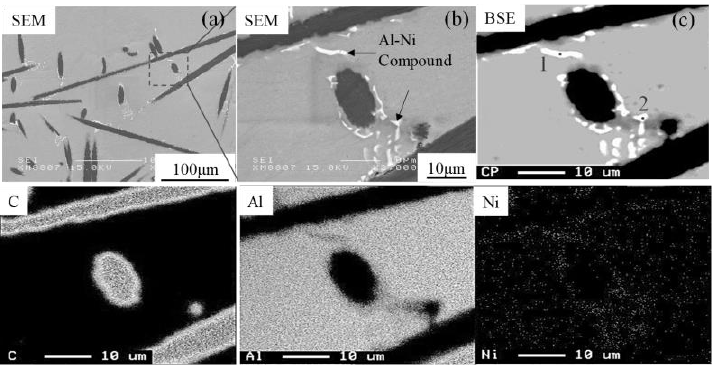
Figure 5. Element mapping analysis of surrounding carbon fiber and Al matrix in Ni plated CSF/A1070 composite. Table 3. Point analysis of Ni plated CSF/A1070 composite by EDS in Figure 5c.